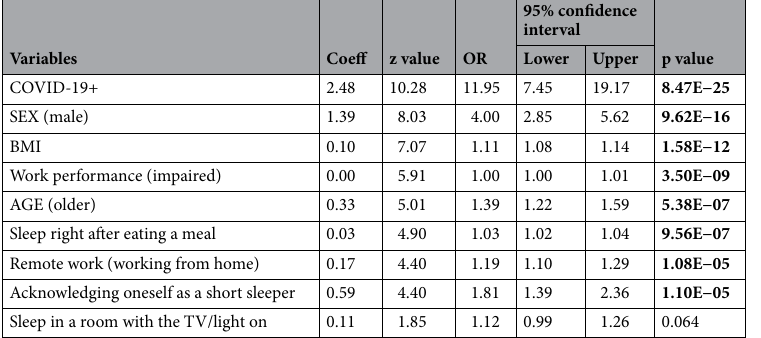
Table 7. Odd ratio and 95% confidence interval for the significant association of the variables with SAS+, all age. Significant values are in